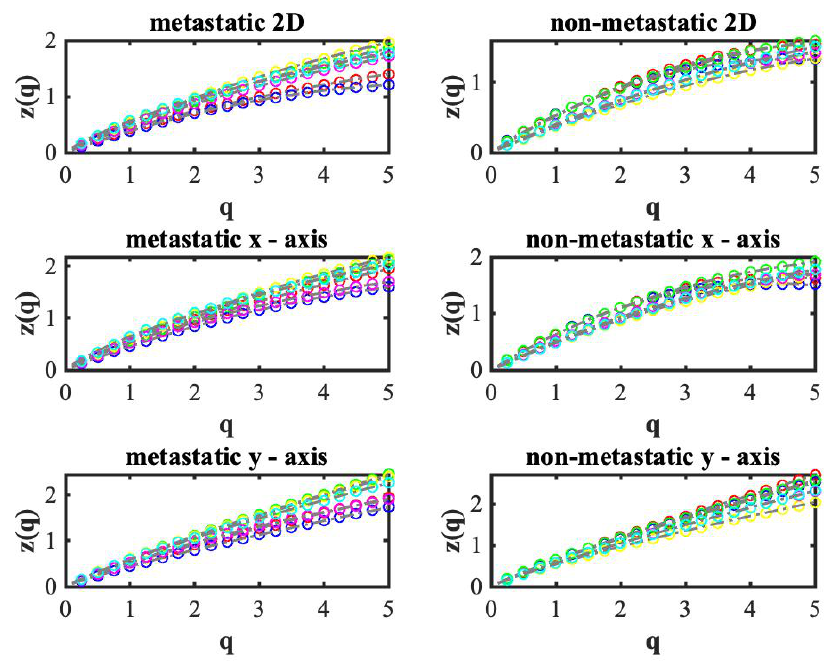
Figure C4. The scaling exponent of the structure functions for six M and six NM histological cross- sections, as was obtained by analyzing the surface roughness, as well as roughness anisotropy in the x and y-axes.